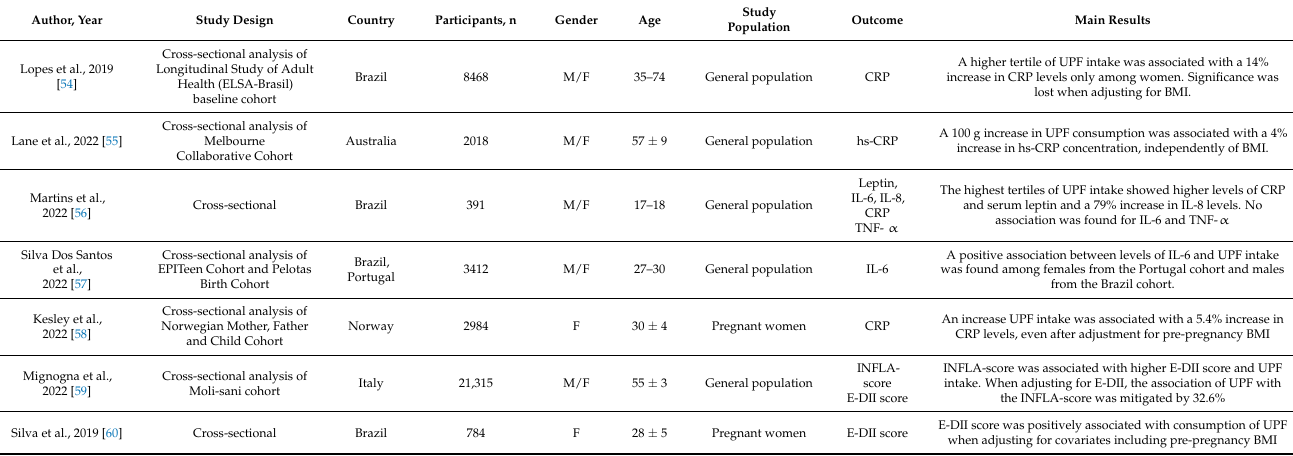
Table 1. Observational studies assessing the relationship between UPF consumption and inflamma- tory biomarkers.